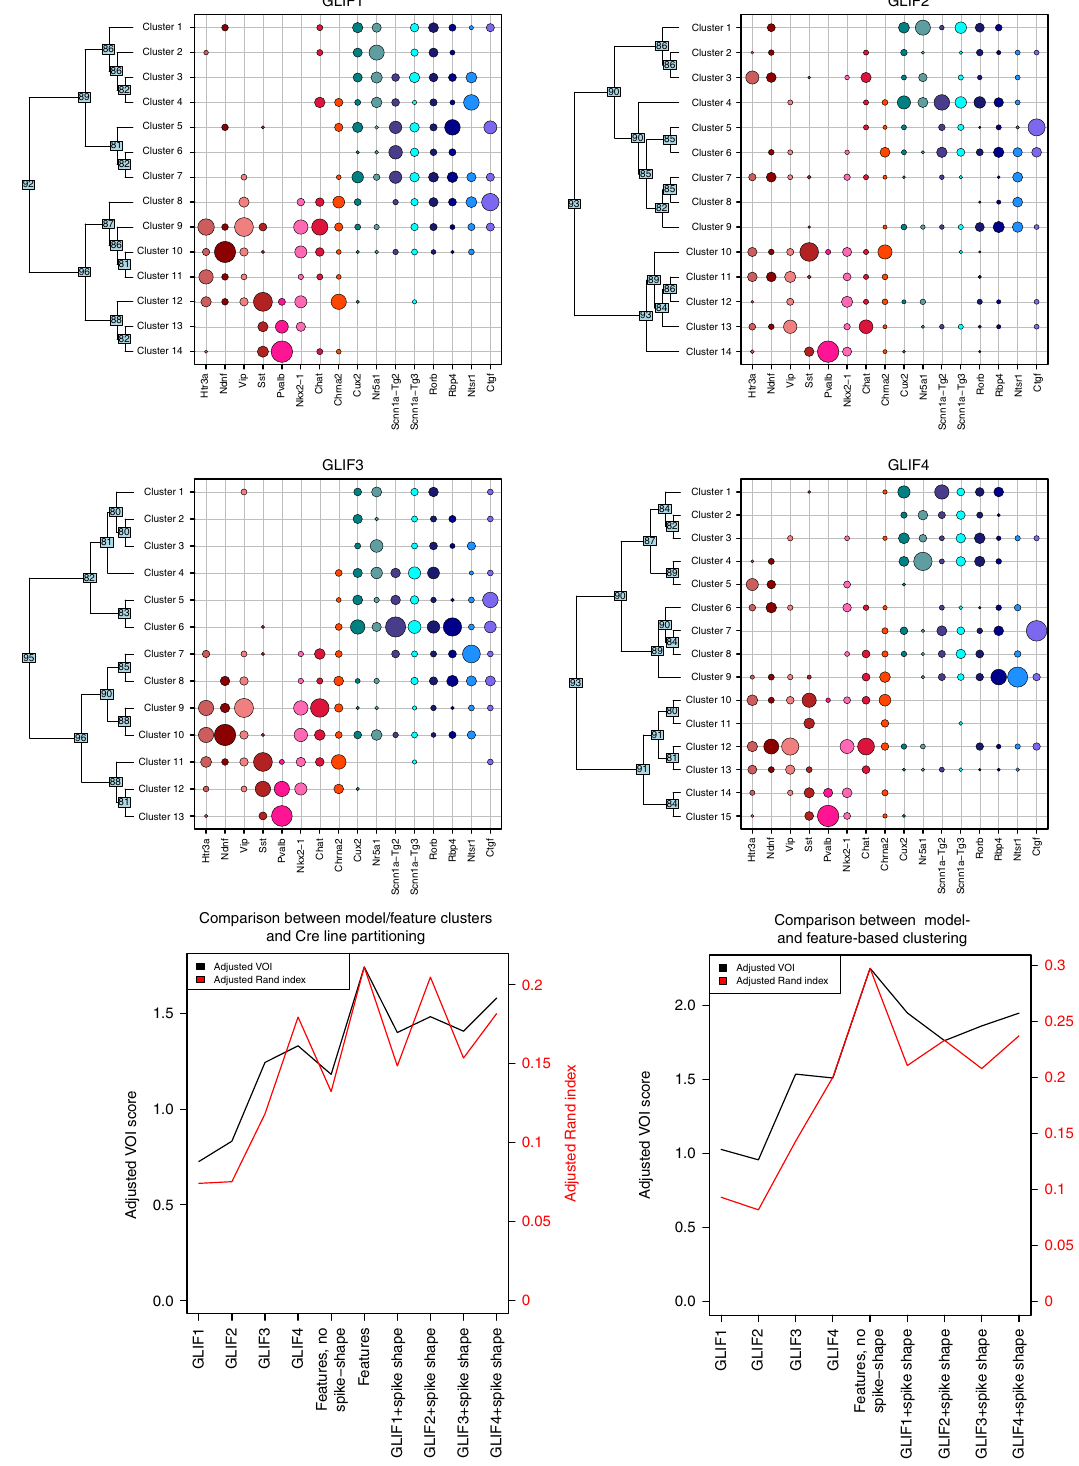
Fig. 7 Iterative binary splitting clustering obtained from using GLIF model parameters plus spike-shape-related feature parameters. The top four panels show cluster versus Cre line composition, similar to Fig. 6. The bottom two panels show the adjusted variation of information metric and the adjusted Rand index for the GLIF model-derived clusters with and without the spike-shape